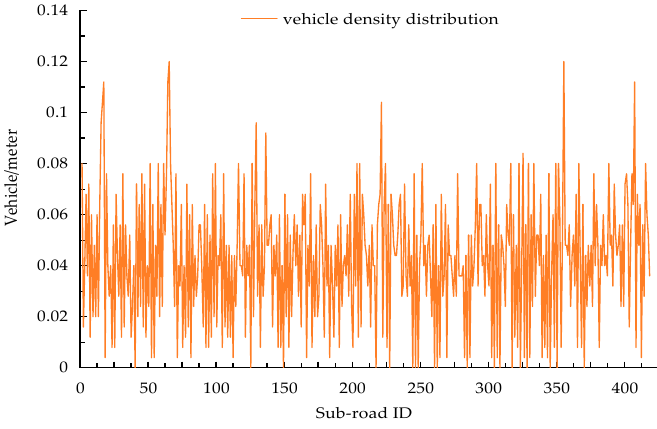
Figure 9. Vehicle density distribution in realistic simulation.